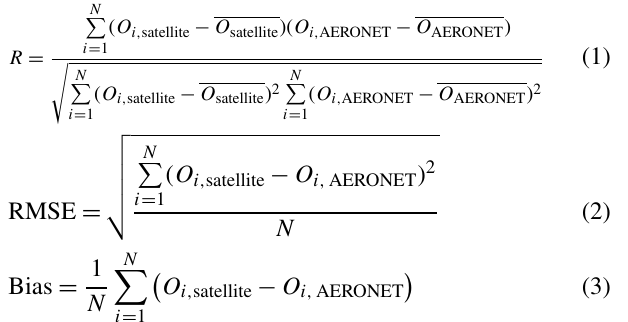
Fig. 1. The minimal number of accepted satellite data pix- els within the window is 1 over land and 41 over